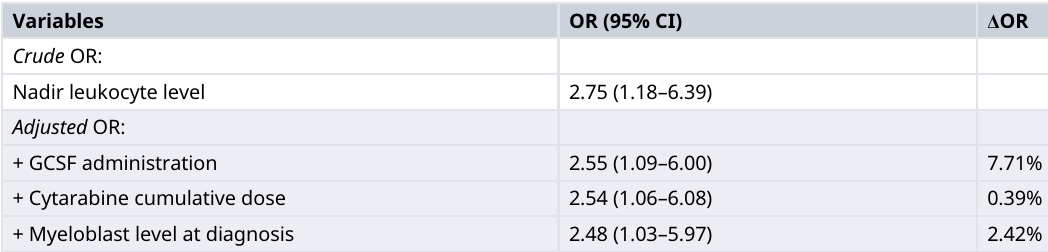
Table 3. Multivariate analysis